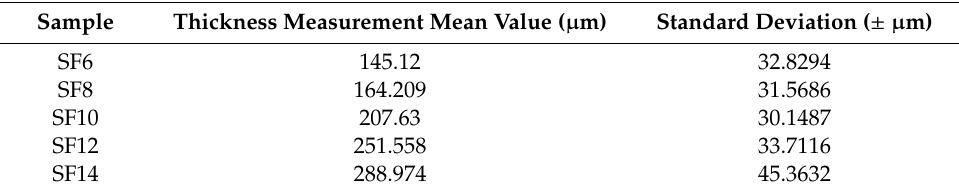
Table 2. Results of membrane thickness measurements of seven membranes per casting concentration and four measuring points per membrane.